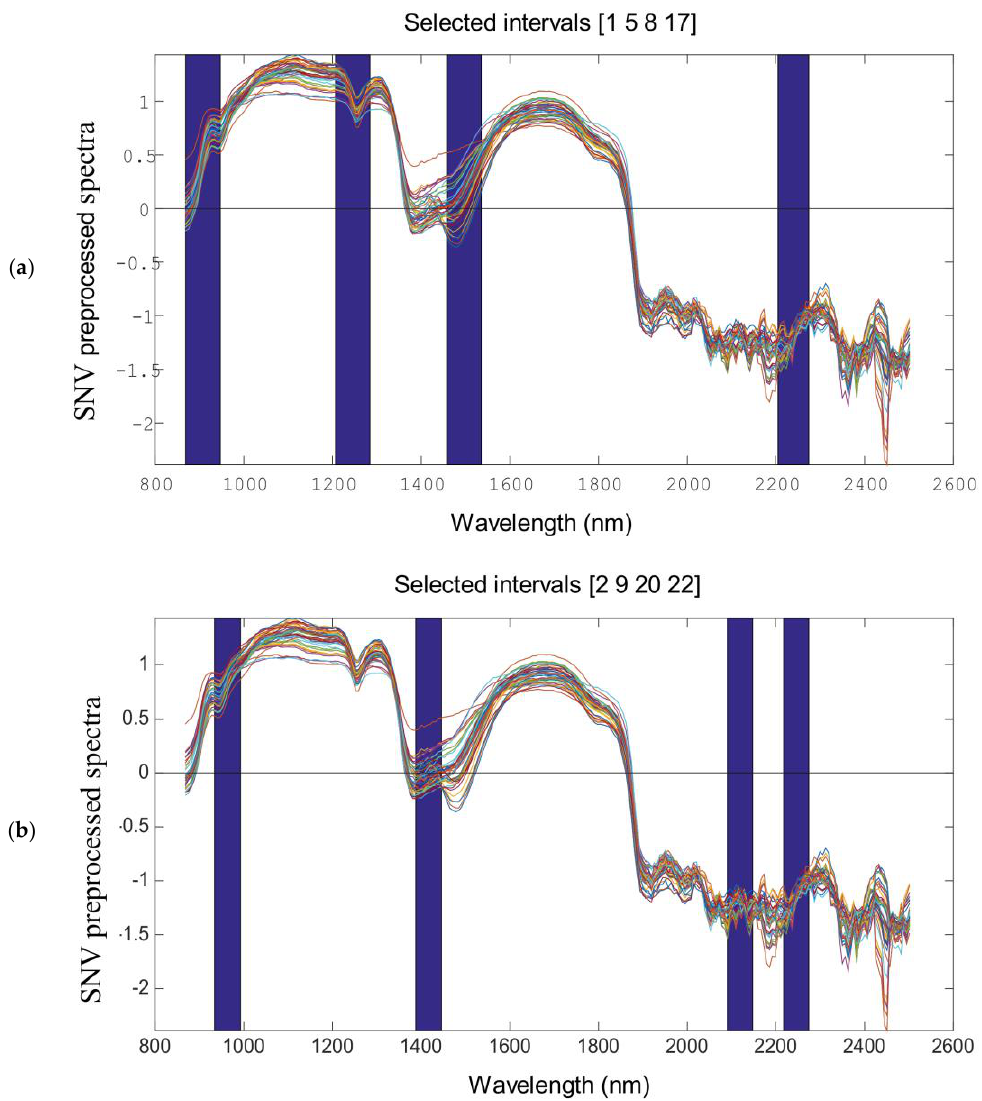
Figure 2. Optimal spectral regions of SH content and SS content selected by Si-PLS ( a ) SH content ( b ) SS content.